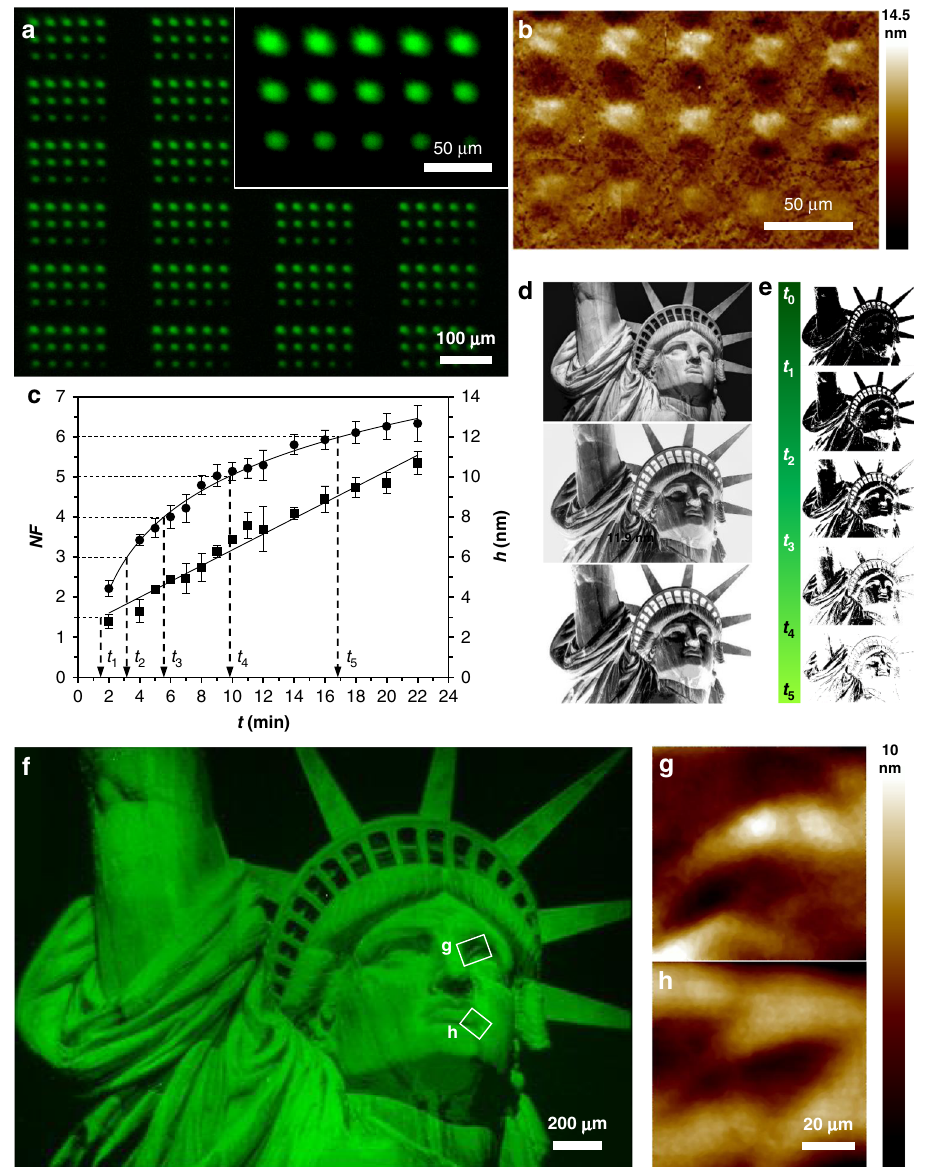
Fig. 2 Control over height and position. a Fluorescence microscopy image ( λ ex = 451.5 ‒ 486.5 nm, λ em = 540 – 580 nm) of 3 × 5 patterns consisting of polymer brush features printed at 15 different t to study the effect of t on NF and h . Inset is a magni fi ed image of one of the arrays with t from 2 ‒ 22 min. b Composite of eight AFM height images corresponding to one of the arrays shown in a . c Dependence of NF (circles) and h (squares) with t . Error bars correspond to the standard deviation of fi ve measurements for NF and three measurements for h . d Original black and white picture of Statue of Liberty (This image is not covered by the article CC BY license. Image credit to Oliver Kuehl. All rights reserved, used with permission.), inverted image, and converted to fi ve gray levels, from top to bottom, respectively. e Threshold images uploaded to the CPU controller corresponding to the fi ve different t required to obtain a polymer brush pattern (300:1 MMA:FMA) with fi ve different NF and h levels shown in f . g , h AFM height measurements from the areas marked with white boxes in f total time of t 5 , which corresponds to the longest exposure time image, so each DMD mirror projects a single pixel with a corresponding width of 4.3 μ m. The image was then inverted (i.e., longest polymers). Using the kinetic fi t obtained in Fig. 2c, (Fig. 2b) and converted to fi ve levels of gray (Fig. 2c), and fi nally, we calculated the exposure times ( t 0 = 0; t 1 = 1.37; t 2 = 3.17; t 3 = fi ve black and white images based upon fi ve threshold levels 5.55; t 4 = 9.70; and t 5 = 16.97 min) required at each pixel for (Fig. 2d) were created. Each black pixel of each image is translated by the instrument into one mirror projecting light to the surface. To create the images, we start with all the black pixels ON at t 0 = 0 (Fig. 2e), and we sequentially turn mirrors OFF to obtain polymers of different heights at the desired positions. Finally, all mirrors are turned OFF at t 5 . The last mirrors turning OFF, in t 5 , are the ones that have been ON during all the process and for a